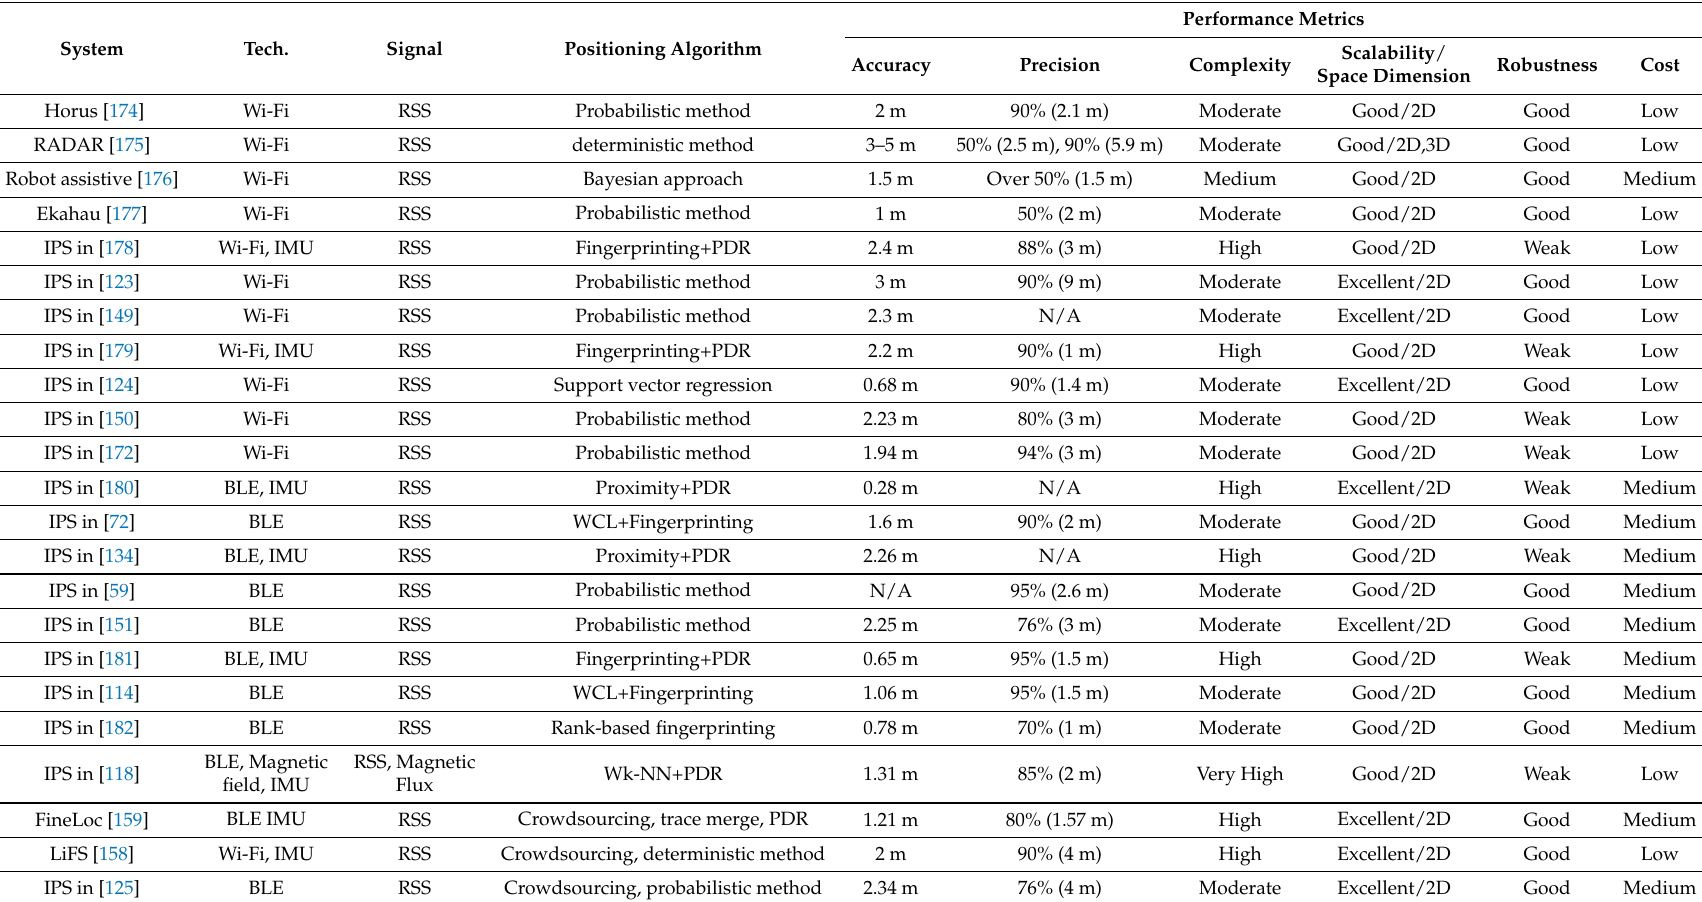
Table 3. Wireless technology (Wi-Fi and BLE)-based localization system and